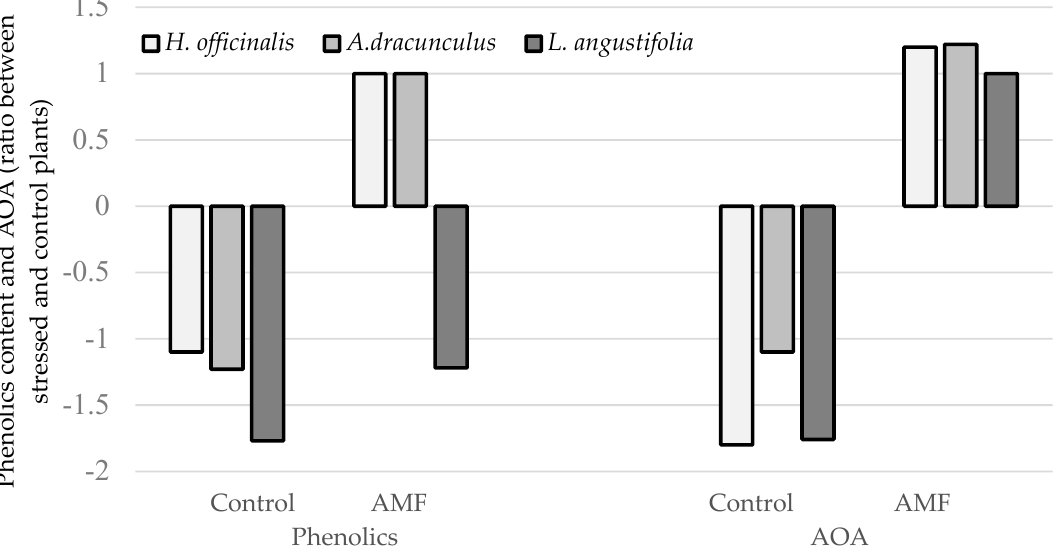
Figure 3. Effect of AMF inoculation on plant phenolic content and AOA of aromatic species (compared to plants not subjected to abiotic stress). AOA, antioxidant activity.